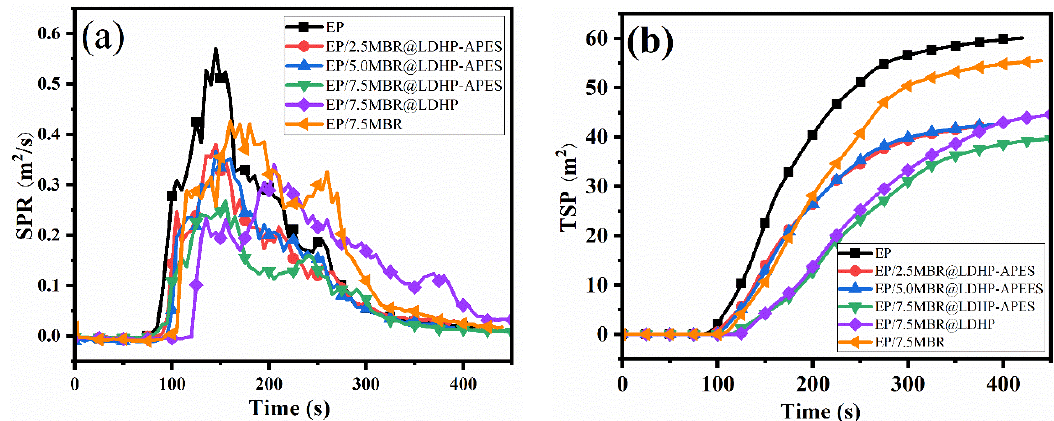
Figure 8. SPR ( a ) and TSP( b ) curves of pure EP and its composites. 322 Table 4. CCT test results for EP and its composites.